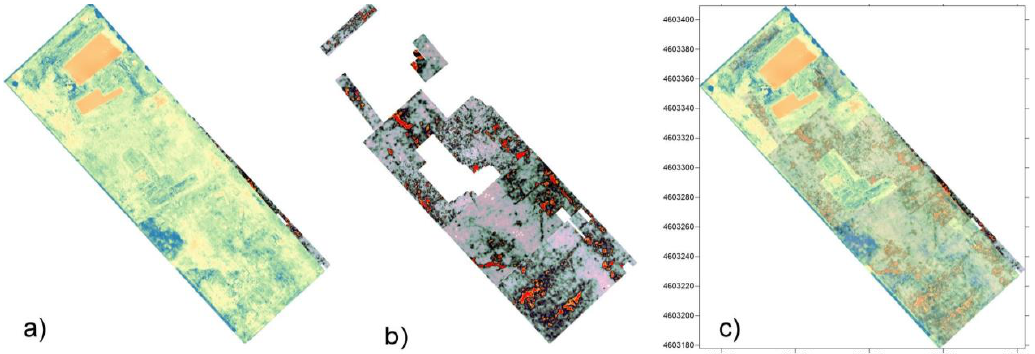
Figure 16. Integration and correspondence of the various information maps produced: ( a ) NDVI ; ( b ) time-slice 200 MHz ( − 0.5/ − 0.7); ( c ) comparison among cropmark anomalies and anomalies identified with GPR.